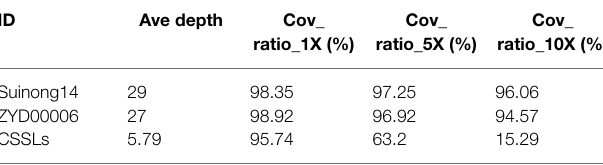
Ave depth: The average coverage depth of the sample; Cov_ratio: The ratio of the number of bases whose coverage depth is at a given depth and above to the total number of bases in the reference